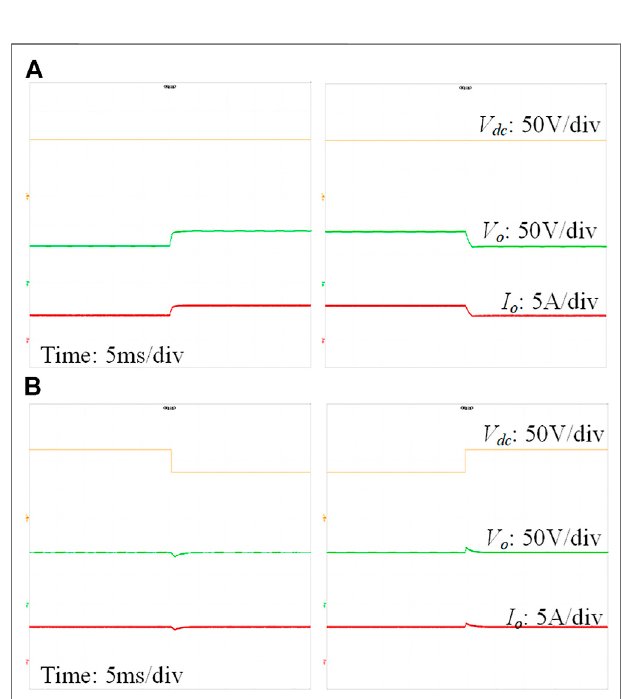
FIGURE12| DynamicwaveformsofthesingleDABconverterwithDPS: (A) when the load steps between half load and full load; (B) when the input voltage steps between 80% and 120% rated